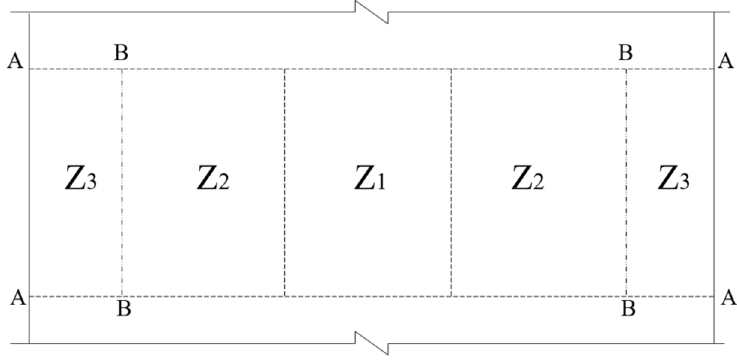
Figure 27. The excavation diagram of evolved methods at the high side wall zone. Table 5. The evolved methods of the high side wall